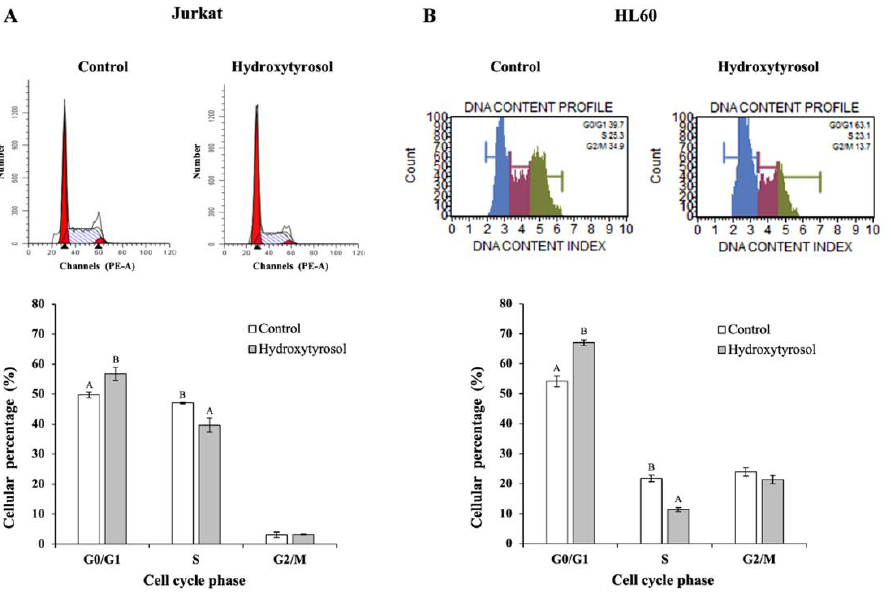
Figure 3. Effect of hydroxytyrosol on the cell cycle in Jurkat (panel A ) and HL60 cell lines (panel B ). Cell cycle analysis was performed with flow cytometry. Panel A corresponds to Jurkat cells and panel B to HL60 cells. Cells were treated with hydroxytyrosol IC 50 for 24 h for Jurkat and 72 h for HL60 cells. Histograms from a representative experiment showing the effects of hydroxytyrosol on the cell cycle profile are represented at the top (Jurkat panel A and HL60 panel B). The lower part represents the percentage of cells in each of the phases of the cell cycle. Values are expressed as mean ± SEM ( n = 3). Different capital letters indicate significant differences between treatments for each phase of the cell cycle ( p <